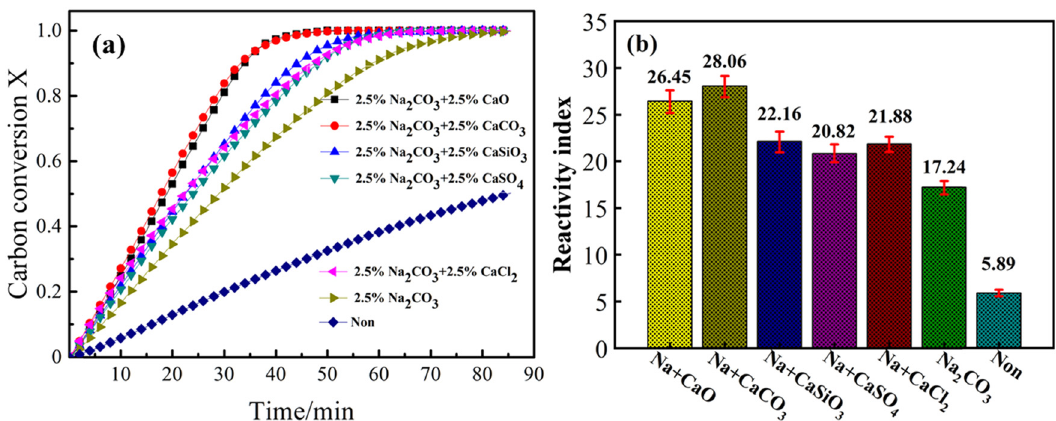
Figure 6: E ff ect of Na/Ca composite fl ux agent on the reactivity of ZJX char: ( a ) gasi fi cation rate and ( b ) gasi fi cation reactivity index.